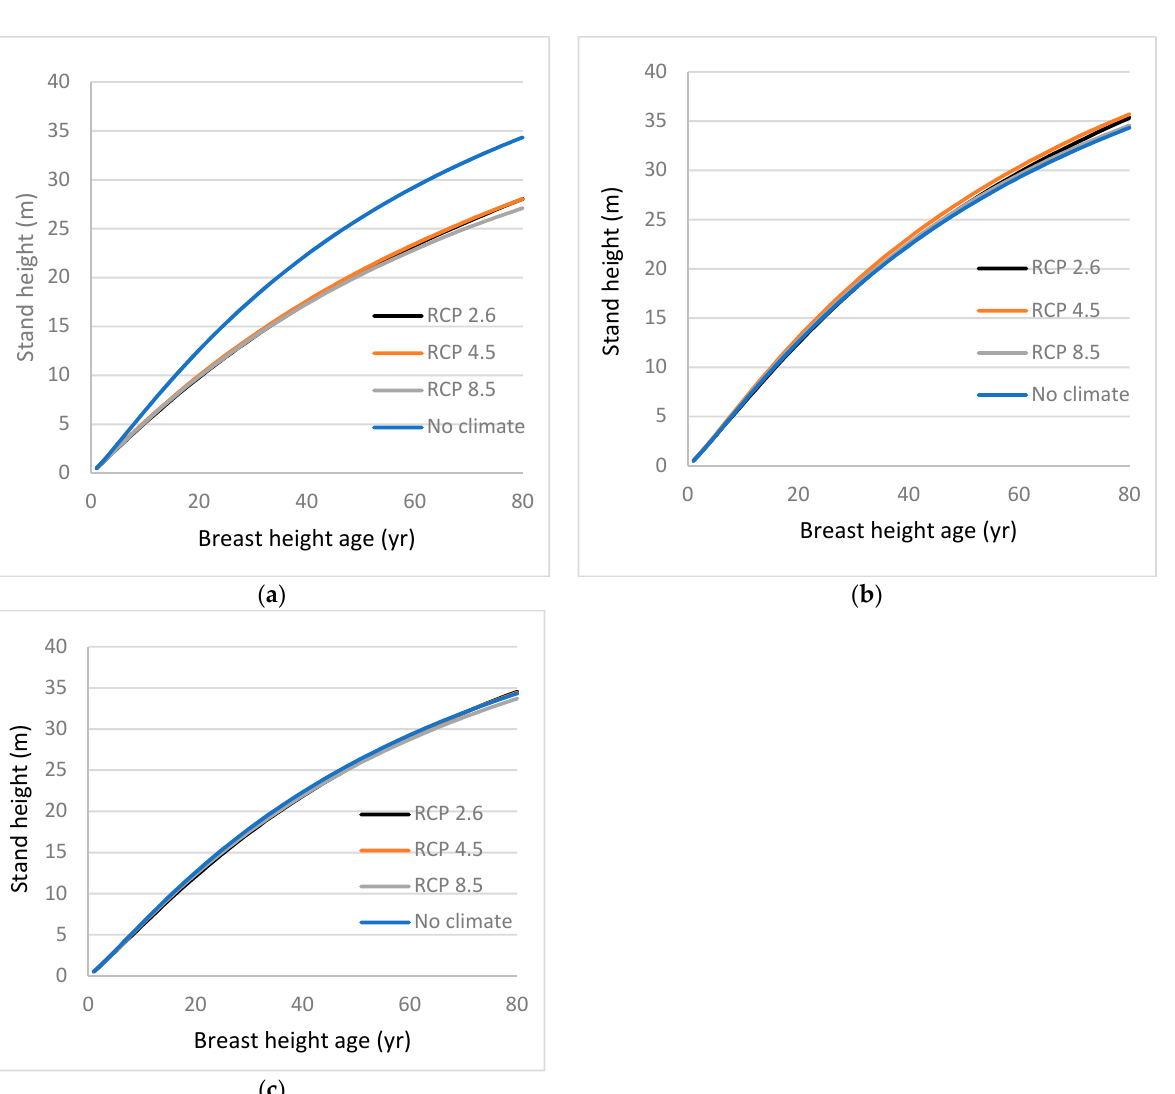
Figure 5. Stand height profiles for white spruce trees generated using projected values of climate variables for the period 2021 to 2080, assuming climate remains stable (no climate) or warms (RCPs 2.6, 4.5, and 8.5), in Equation (5) for ( a ) southeastern (near Barrie), ( b ) central (near Hearst), and ( c ) western (near Red Lake) Ontario, Canada. Climate variables were projected for locations close to sample sites using three emissions trajectories known as representative concentration pathways (RCPs).